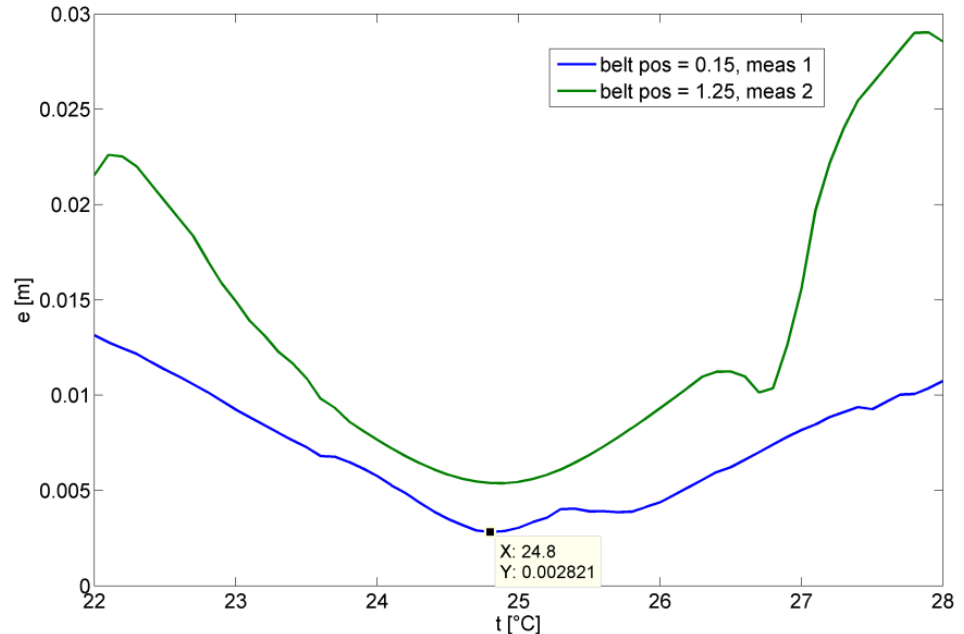
Figure 17. Determination of temperature using reference positions.